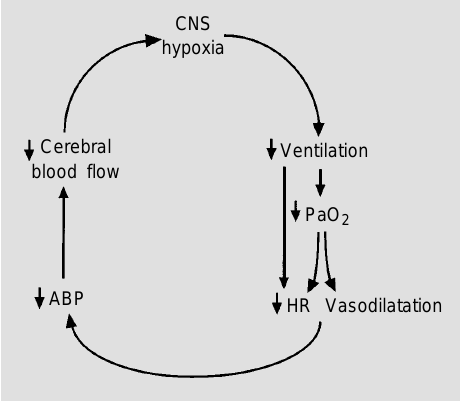
Figure 4 - The proposed posi- tive feedback loop that may de- velop during systemic hypoxia, particularly in small adult mam- mals and neonates. CNS, Cen- tral nervous system; HR, heart rate; ABP, arterial blood pres-